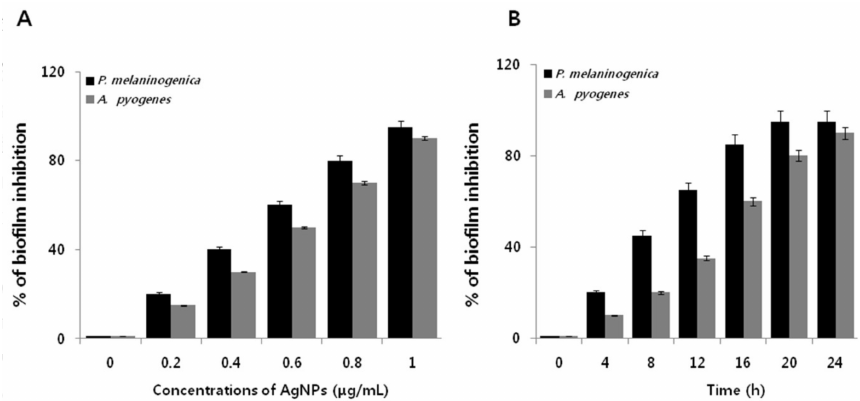
Figure 4. Anti-biofilm activity of AgNPs on P. melaninogenica and A. pyogenes. ( A ) P. melaninogenica and A. pyogenes were incubated with various concentrations of AgNPs. Anti-biofilm activity was measured using 96-well flat-bottom polystyrene tissue culture plates. ( B ) P. melaninogenica and A. pyogenes cells were incubated with 0.8 and 1.0 µ g/mL of AgNPs respectively for 24